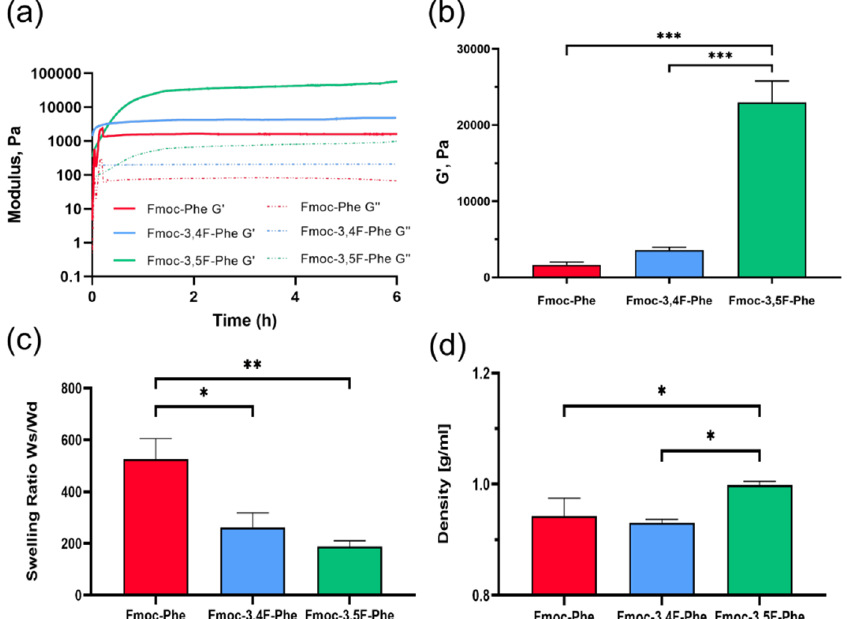
Figure 3. Physical Properties of Fmoc-Phe and the double fluorinated Fmoc-Phe hydrogels. ( a ) In situ time sweep oscillation measurements of storage and loss modulus. ( b ) The averaged storage modulus, G ′ , one-hour post-gelation. ( c ) Swelling ratio. ( d ) Density measurement. Representative results from three independent experiments are presented as mean ± SD; * p < 0.05, ** p < 0.01 and *** p < 0.001 as measured using one-way ANOVA.